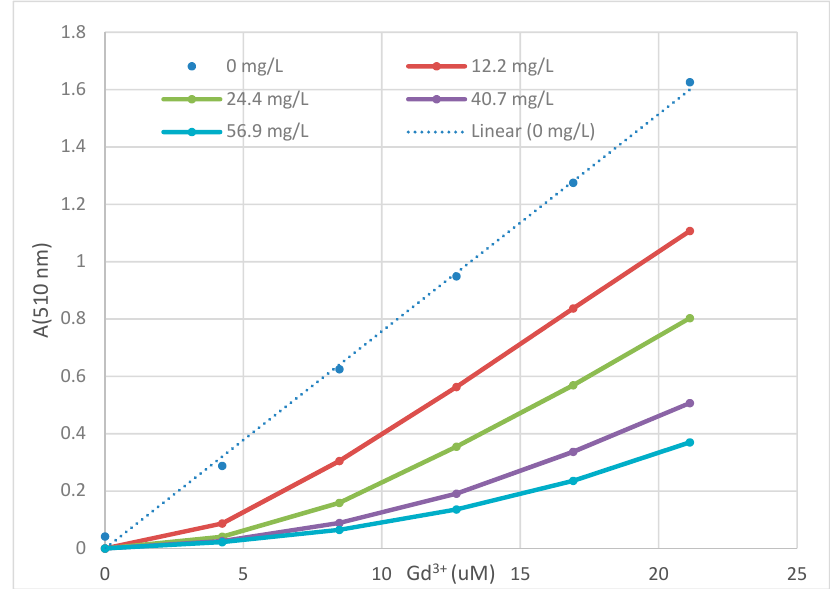
Figure 7. The titration data for the various concentrations of the TeraVita humic acid at pH 8 and at various humic acid concentrations are summarized. The curvature in the plot indicates finite complexing capacity.